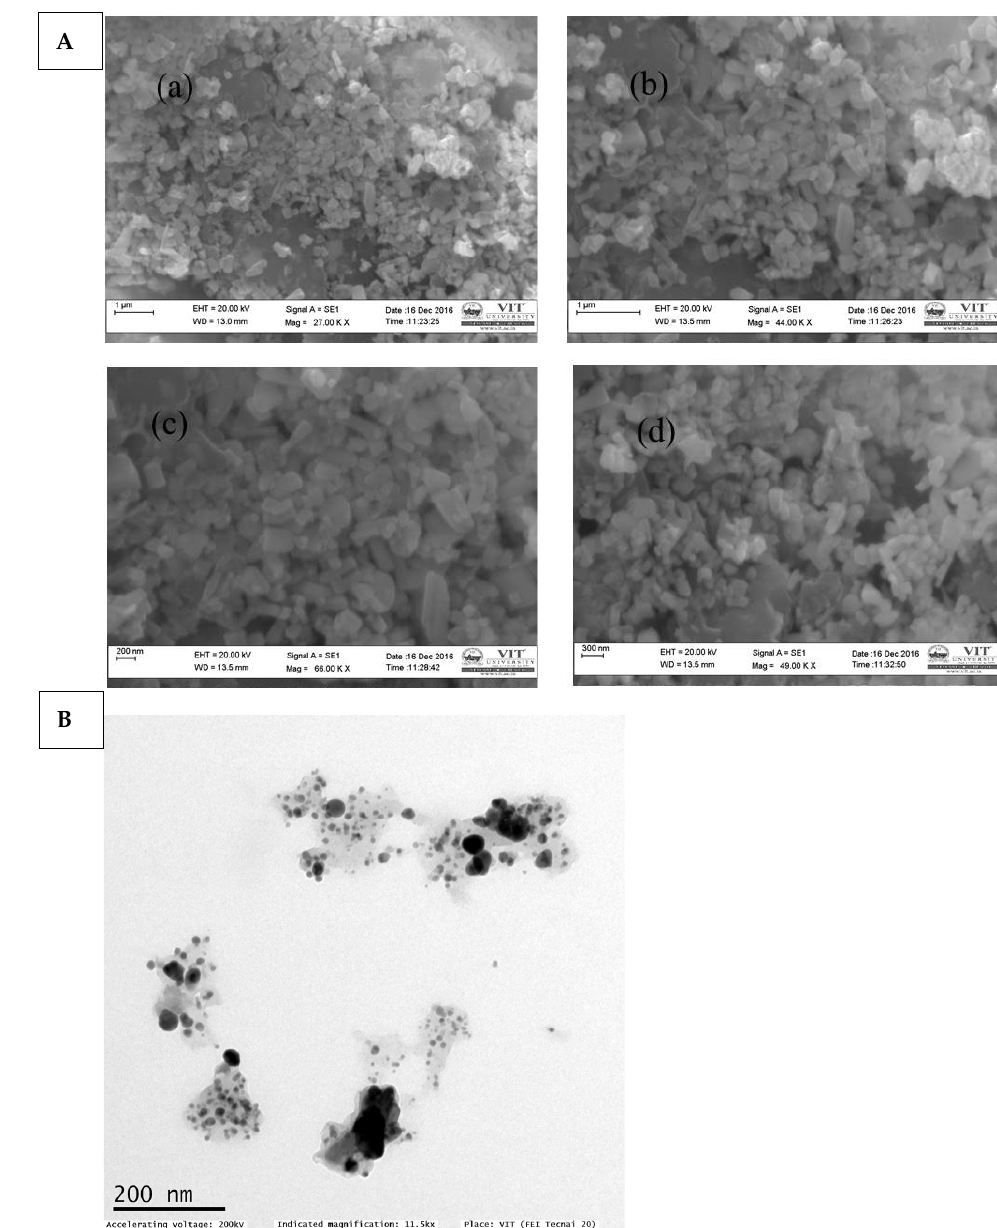
Figure 3. ( A ) SEM (Nanoparticle view under 27.00 KX (a), 44.00 KX (b), 66.00 KX (c), 49.00 KX (d) magnification) and ( B ) TEM study of ZnO NPs that were generated utilizing the extract of M. indica seeds.